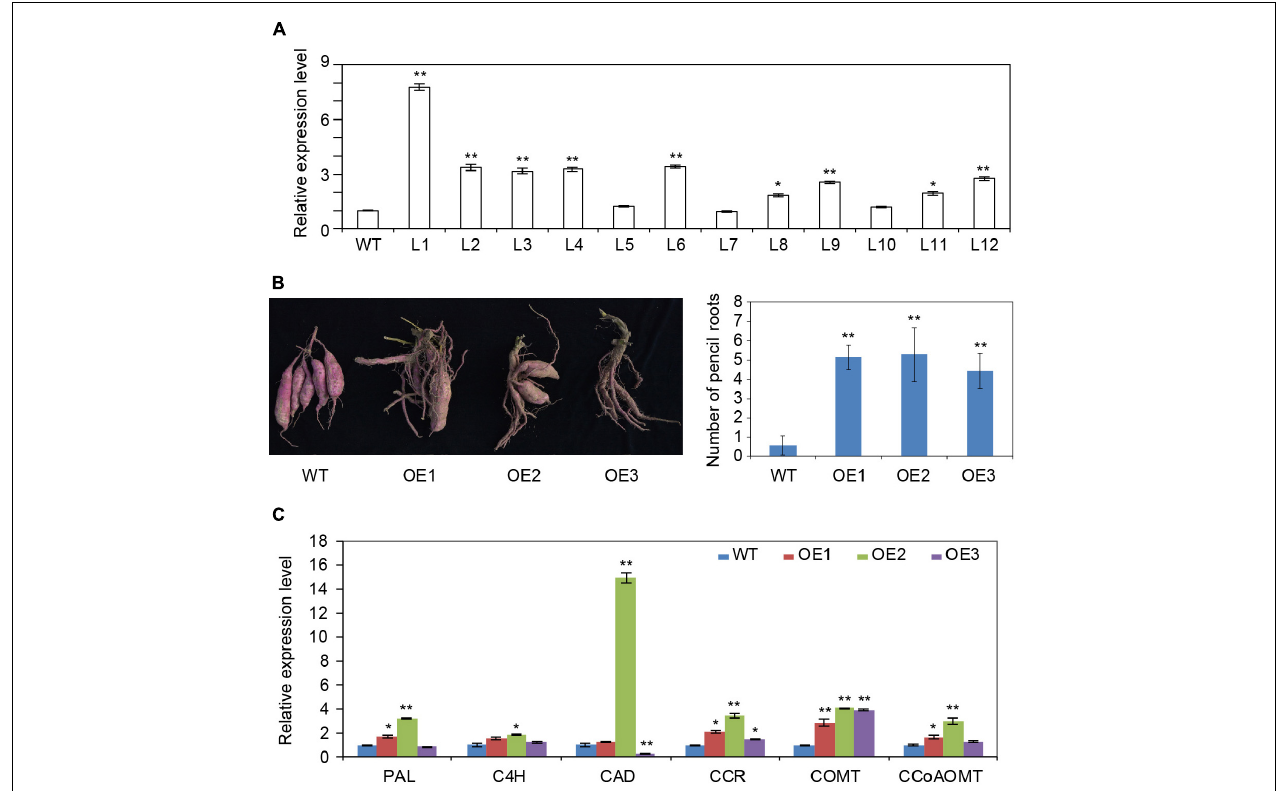
FIGURE 5 | Overexpression of IbRAP2.4 in sweetpotato. (A) qRT-PCR analysis of sweetpotato transgenic lines overexpressing IbRAP2.4 (L1 to L12). (B) Reduced number of storage roots (SRs) but increased number of pencil roots (PRs) produced by representative transgenic lines (OE1 to OE3). (C) Expression of genes involved in lignin biosynthesis. Data represent mean ± SD of three biological replicates. The asterisks represent significant differences from the WT at * P < 0.05 or ** P < 0.01.